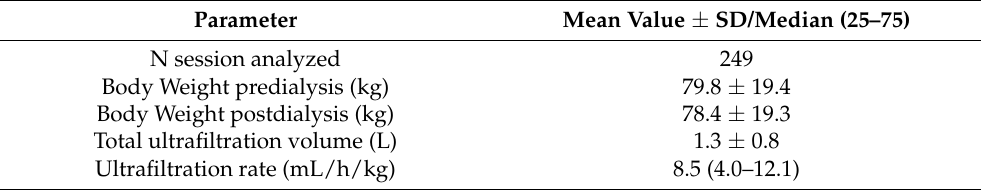
Table 2. Pre/post-dialysis body weight and ultrafiltration using the Physidia S 3 daily home dialysis monitor. Values were described by using mean values ± standard deviation or median (percentile 25–percentile 75) according to their distribution.